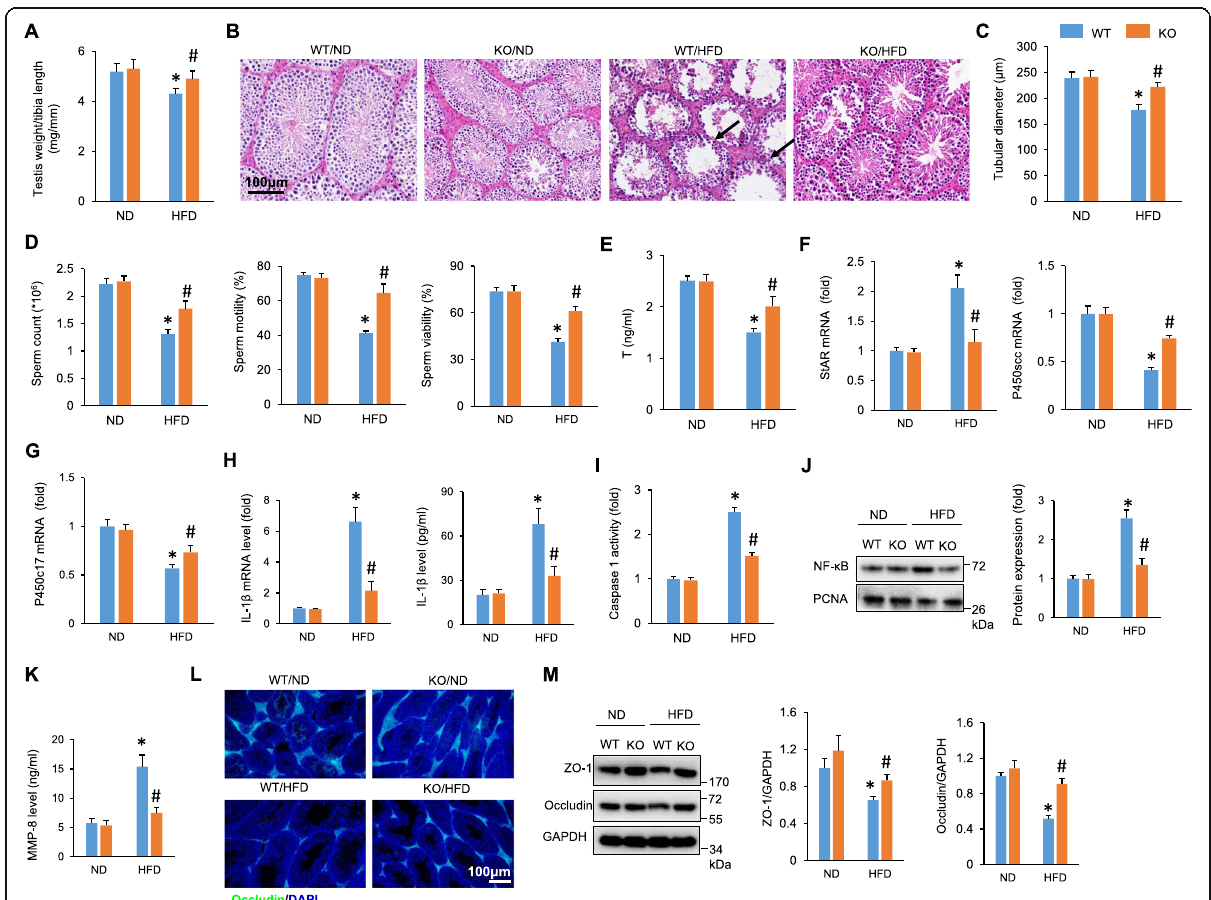
Fig. 4 NLRP3 deficiency protected against HFD-induced subfertility in male mice. A Statistical results of the ratio of testis weight and tibia length in the indicated groups ( n = 12). B , C HE staining of testes and tubular diameter from the indicated groups ( n = 6). Black arrows indicate destruction of the BTB. D Sperm count, viability, and motility of the indicated groups ( n = 6). E Serum testosterone concentration of the indicated groups ( n = 6). F , G The mRNA of steroidogenic enzymes in the testes of obese mice ( n = 6). H The expression of IL-1 β in the testes of obese mice ( n = 6). I Caspase 1 activity in the testes of obese mice ( n = 6). J The nuclear accumulation of NF- κ B was detected in the testes of obese mice ( n = 6). K MMP-8 expression in the testes of obese mice ( n = 6). L Immunofluorescence of occludin in the testes of obese mice ( n = 5). M The protein expression of ZO-1 and occludin in the testes of obese mice ( n = 6). Data are presented as the mean ± SD. Statistical analysis was carried out by one-way ANOVA. * P < 0.05 vs WT/ND; # P < 0.05 vs